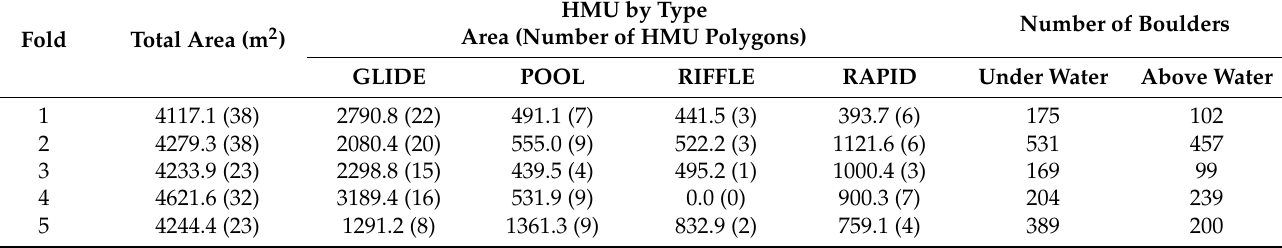
( b ) Figure 7. Object loss ( a ) and precision ( b ) for validation datasets during training epochs in K-fold cross-validation.